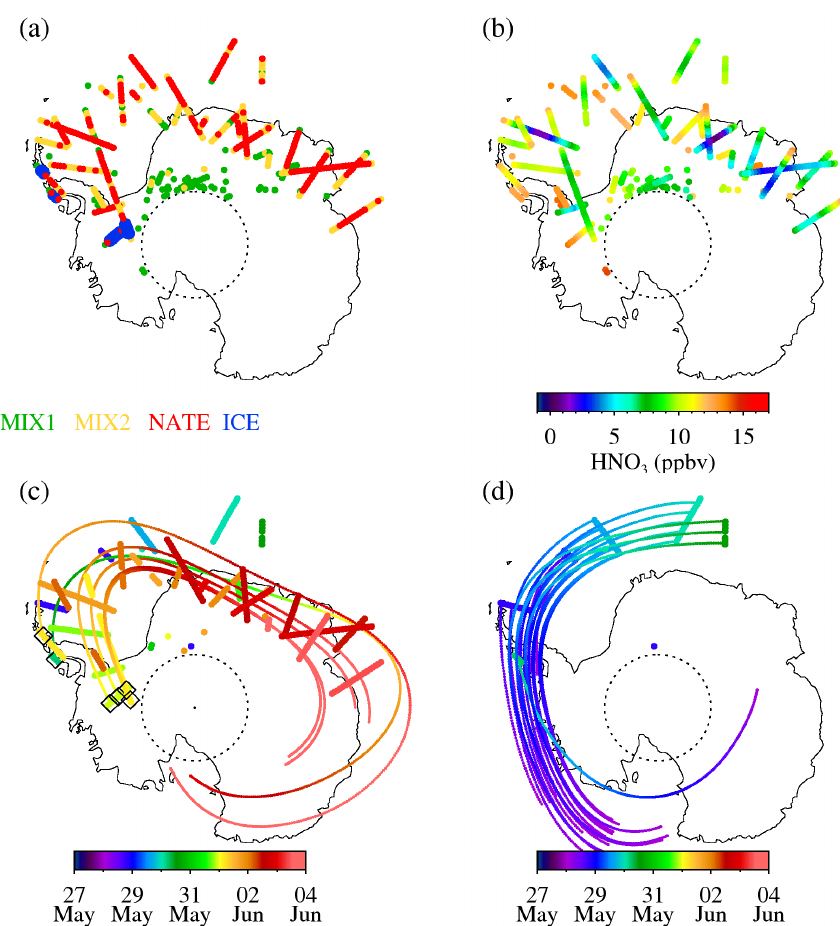
Fig. 16. Geographic distribution of CALIOP and MLS data at an altitude of 22km for the period 28 May–3 June 2008. A dashed latitude circle at 82 ◦ S indicates the limit of the CALIOP and MLS observations. (a) CALIOP PSC classification for solid types only (MIX1 (green), MIX2 (yellow), ICE (blue)) and including the enhanced-NAT sub-category (NATE (red)). (b) MLS HNO 3 corresponding to the PSC locations in (a) , typical unperturbed values would be ∼ 12ppbv. (c) Forward trajectories on the 500K potential temperature surface were launched from the locations shown by the diamond symbols at the times when PSCs classified as ICE types by CALIOP were detected. (d) Backward trajectories on the 500K potential temperature surface were launched from a representative sample of points along the CALIOP orbit tracks at the times when MIX2 PSCs were detected during 28–30 May. The color scales in (c,d) indicate both the PSC observation times and the time along the trajectory tracks, such that trajectories passing near or intersecting with observation tracks at near coincident times have similar colors. Only MIX2 PSCs (including NATE) are shown for clarity in (c, d)